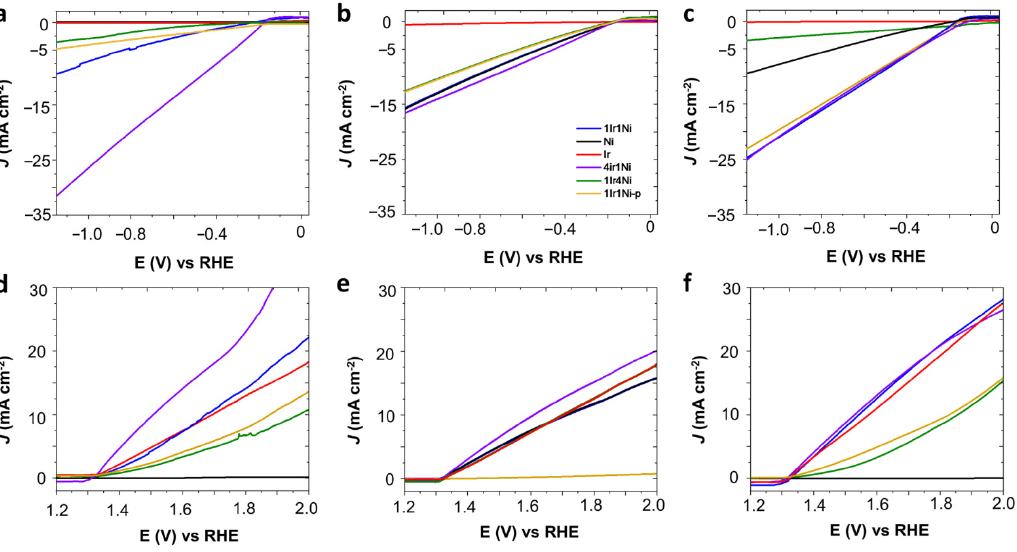
Figure 1. Linear sweep voltammetry (LSV) curves of Ir and Ni metals and alloys on activated carbon matrix; the test was performed at a 50 mV s − 1 scan rate in ( a , d ) 0.1 M NaOH, ( b , e ) 0.1 M Na 2 SO 4 , and ( c , f ) 0.1 M H 2 SO 4 electrolyte at room temperature in the presence of 1 sunlight illumination (1.5 G AM, 100 mW cm − 2 ). The material code was similar in all graphs; refer to ( b ) for the labeling.